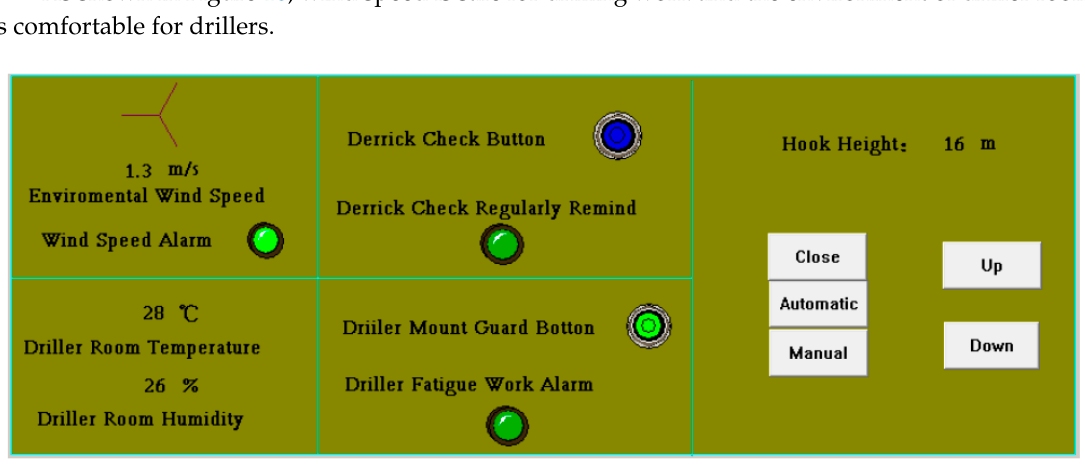
Figure 16. Configuration monitor screen of derrick and driller room.